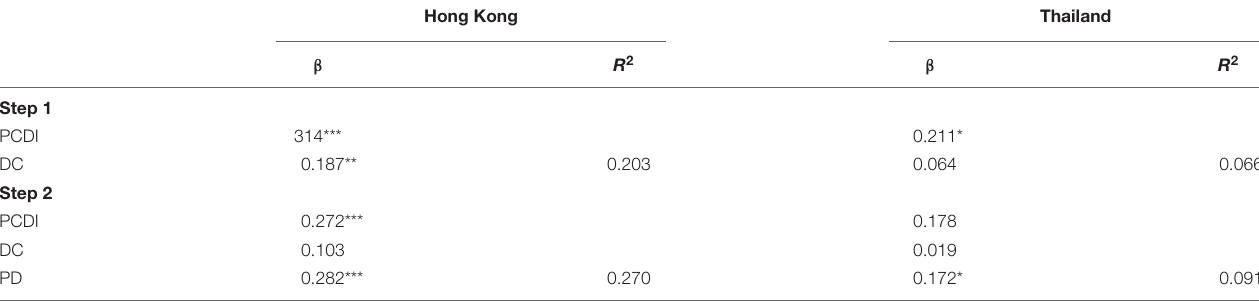
TABLE 5 | Hierarchical regressions: parenting stress subscales predicting general distress.